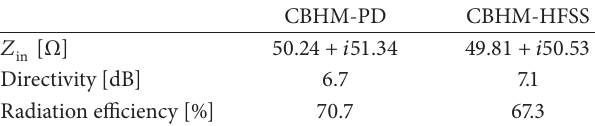
Table 2: Electric characteristics of CBHM